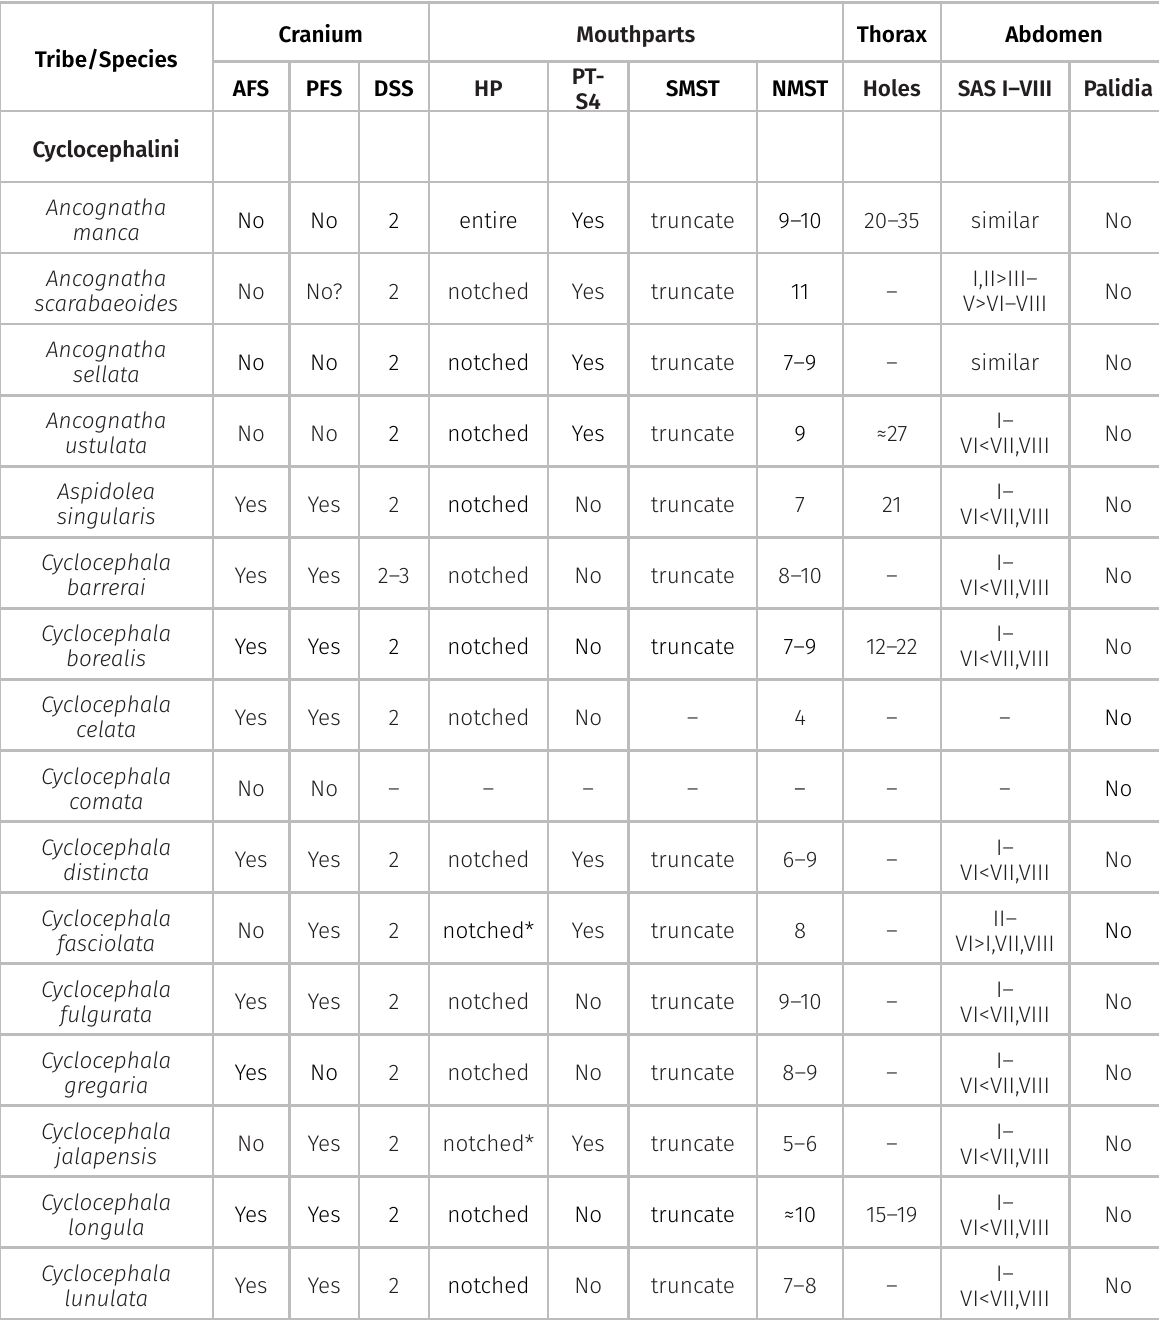
Table III. Main characters used in the systematics of larvae of species of New World Cyclocephalini and Pentodontini. Cranium: color; presence or absence anterior frontal seta (AFS); posterior front seta (PFS); number of dorsal sensory spots (DSS) in antenna. Mouthparts: shape of haptomeral process (HP); presence of post-scissorial tooth on left mandible (PT-S4); shape of maxillary stridulatory teeth (SMST); number of maxillary stridulatory teeth (NMST). Thorax: number of holes in respiratory plate (Holes). Abdomen: size of abdominal spiracles I–VIII (SAS I–VIII); presence or absence of